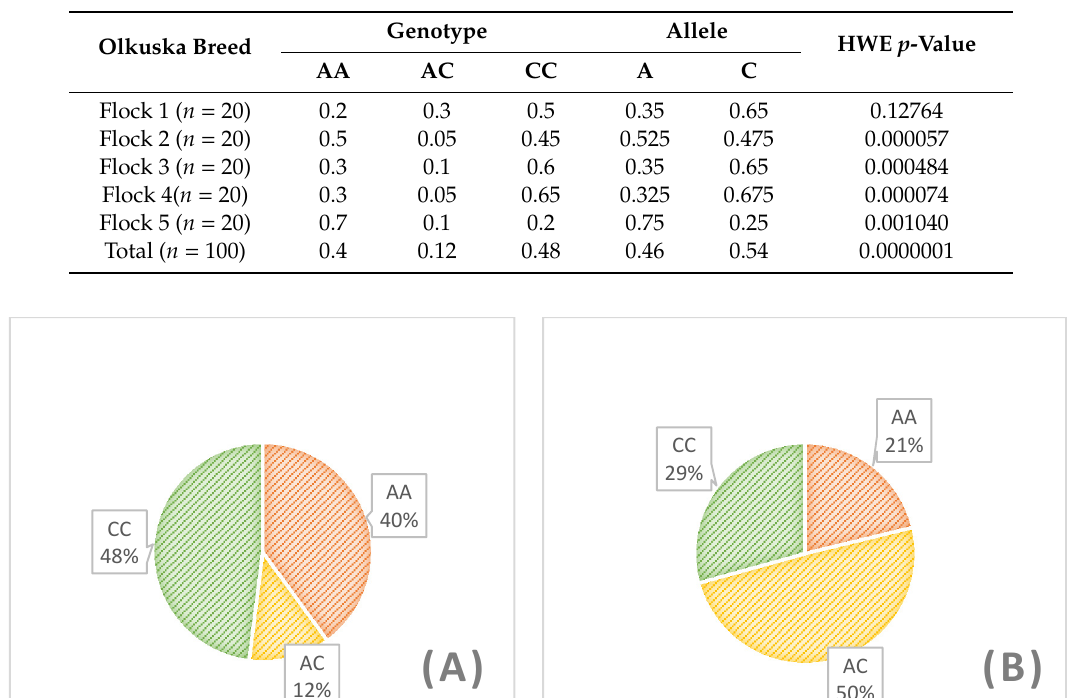
Figure 3. Fragments of chromatograms with the SNP mutation c.1009A > C. The polymorphic sites are marked with an arrow. Table 2. The frequency of genotypes and alleles at the locus of the BMP-15 gene and p -values for deviation from the Hardy–Weinberg equilibrium (HWE).